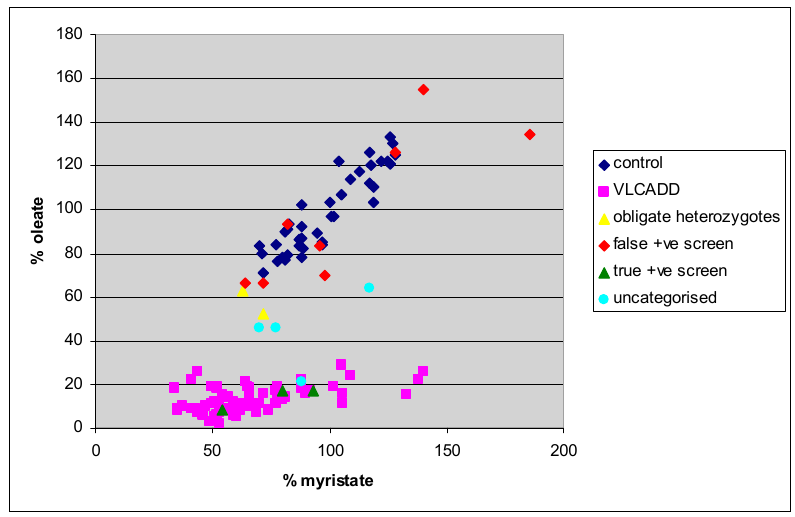
Figure 5. Percentage FAO-flux in VLCADD, obligate heterozygotes, false positive, true positive screened infants and uncategorized cell lines at 41 °C.